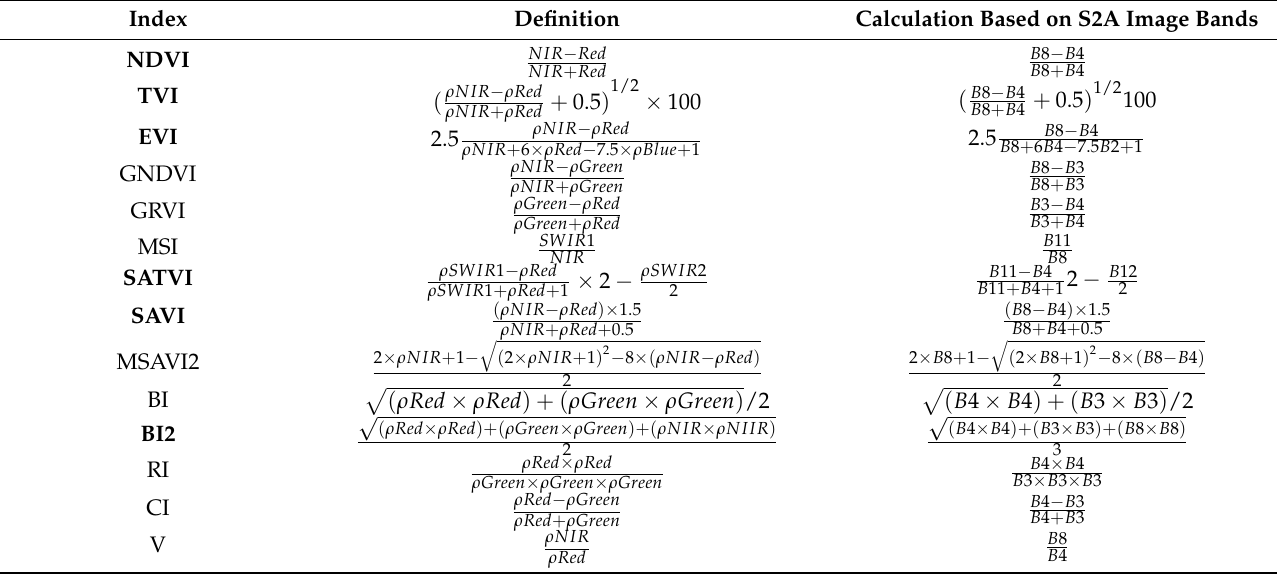
Table 3. Definition and calculation of the selected specific spectral indices based on the Sentinel-2A image reflectance data (see index abbreviation definitions in the